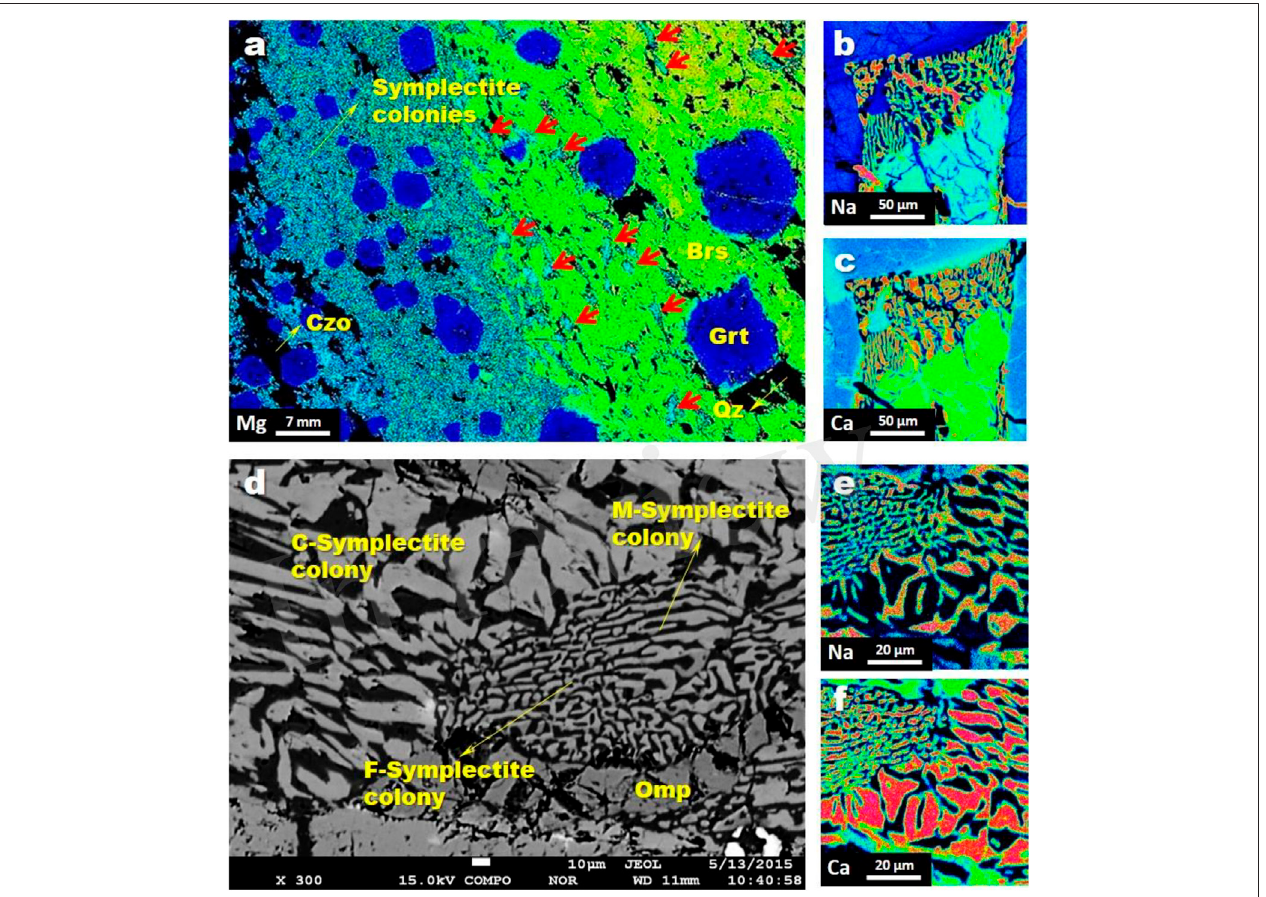
FIGURE 5 | Chemical composition and textural features of omphacite and associated symplectites. (A – C) chemical distribution of Mg, Na, and Ca, respectively. (D – F) show coarse (C), medium (M) and fi ne (F) textural features of the symplectite colonies.